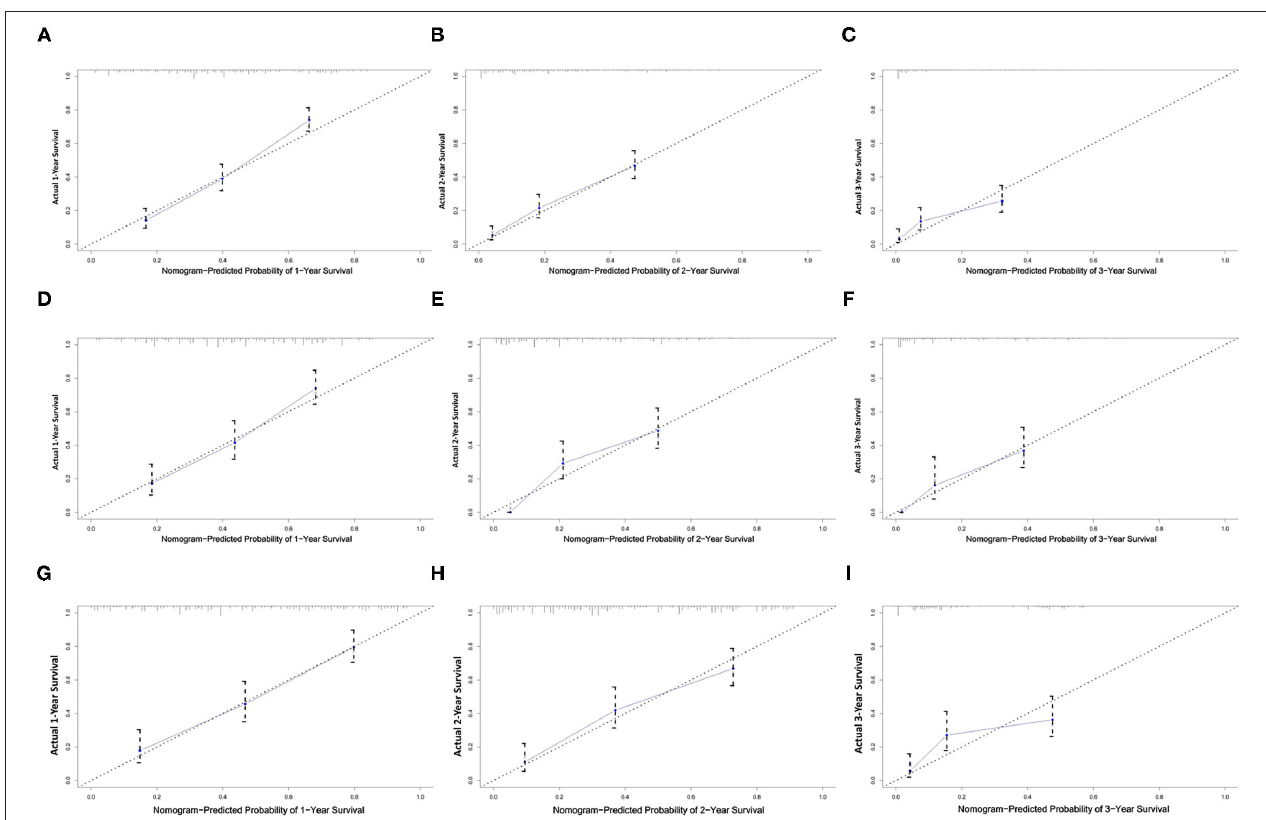
FIGURE 4 | Calibration plots of the nomogram for 1-, 2-, and 3-year OS prediction of the training set (A–C) , internal validation set (D–F) , and external set (G–I) . X-axis represents the nomogram-predicted probability of survival; Y-axis represents the actual OS probability. A perfectly accurate nomogram prediction model would result in a plot that the observed and predicted probabilities for given groups fall along the line. Dots with bars represent nomogram-predicted probabilities along with 95% confidence interval. values of the nomogram for predicting the 1-, 2-, and